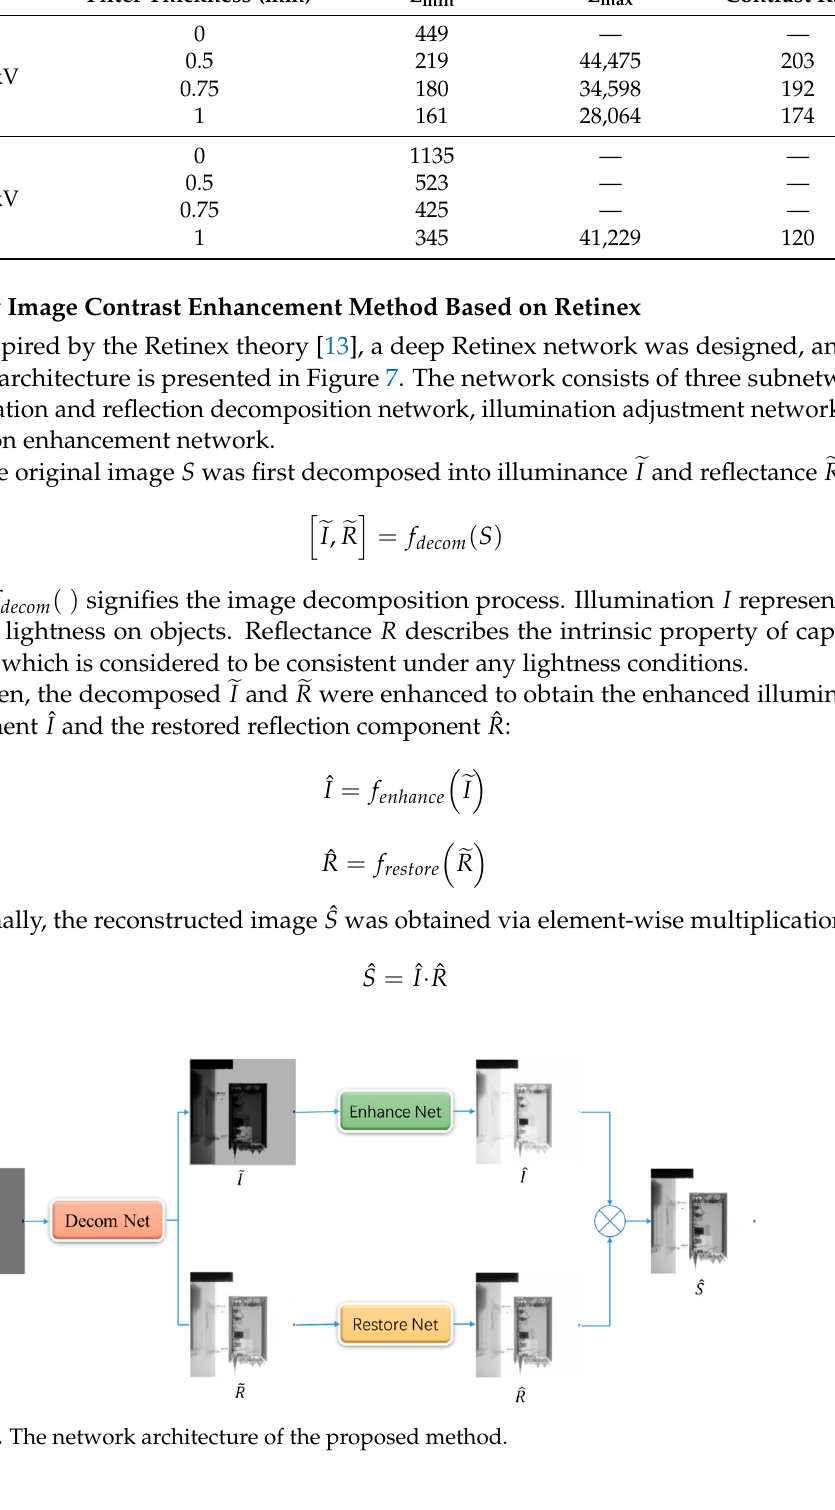
Table 1. Image contrast of Fe (20 mm thick) and Al (1 mm thick). Filter Thickness (mm)